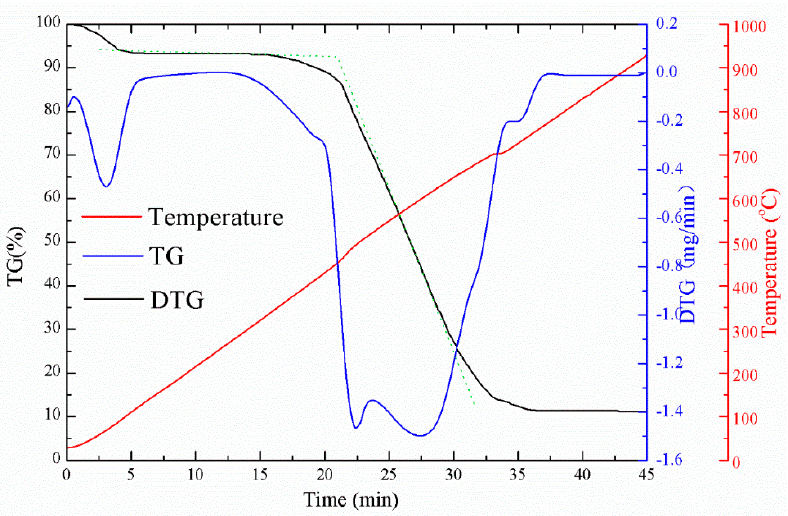
Figure 7. Diagram of ignition point determined by the powder coke thermal gravity-differential thermal gravity (TG-DTG) combined method.